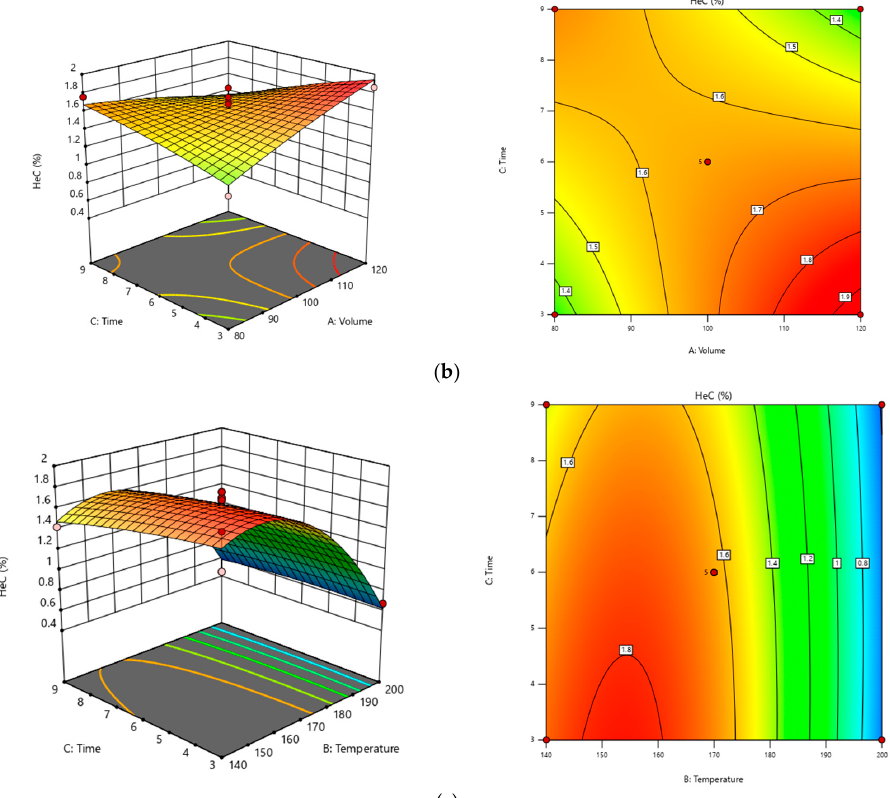
Figure 1. Response surface and contour plots for factors influencing yields of saponin extraction include: ( a ) temperature and volume; ( b ) volume and time; and ( c ) temperature and time.